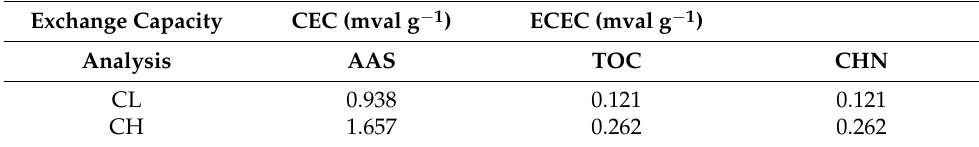
Table 3. Exchange capacities of zeolitic